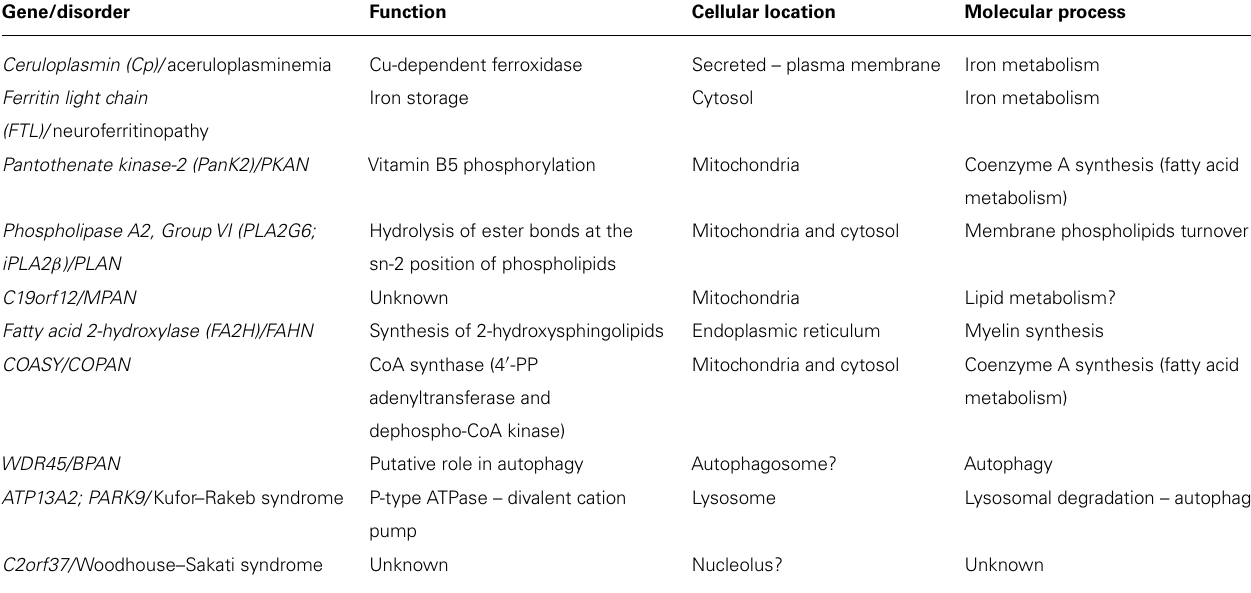
Table 2 | Causative genes of the neurodegeneration with brain iron accumulation